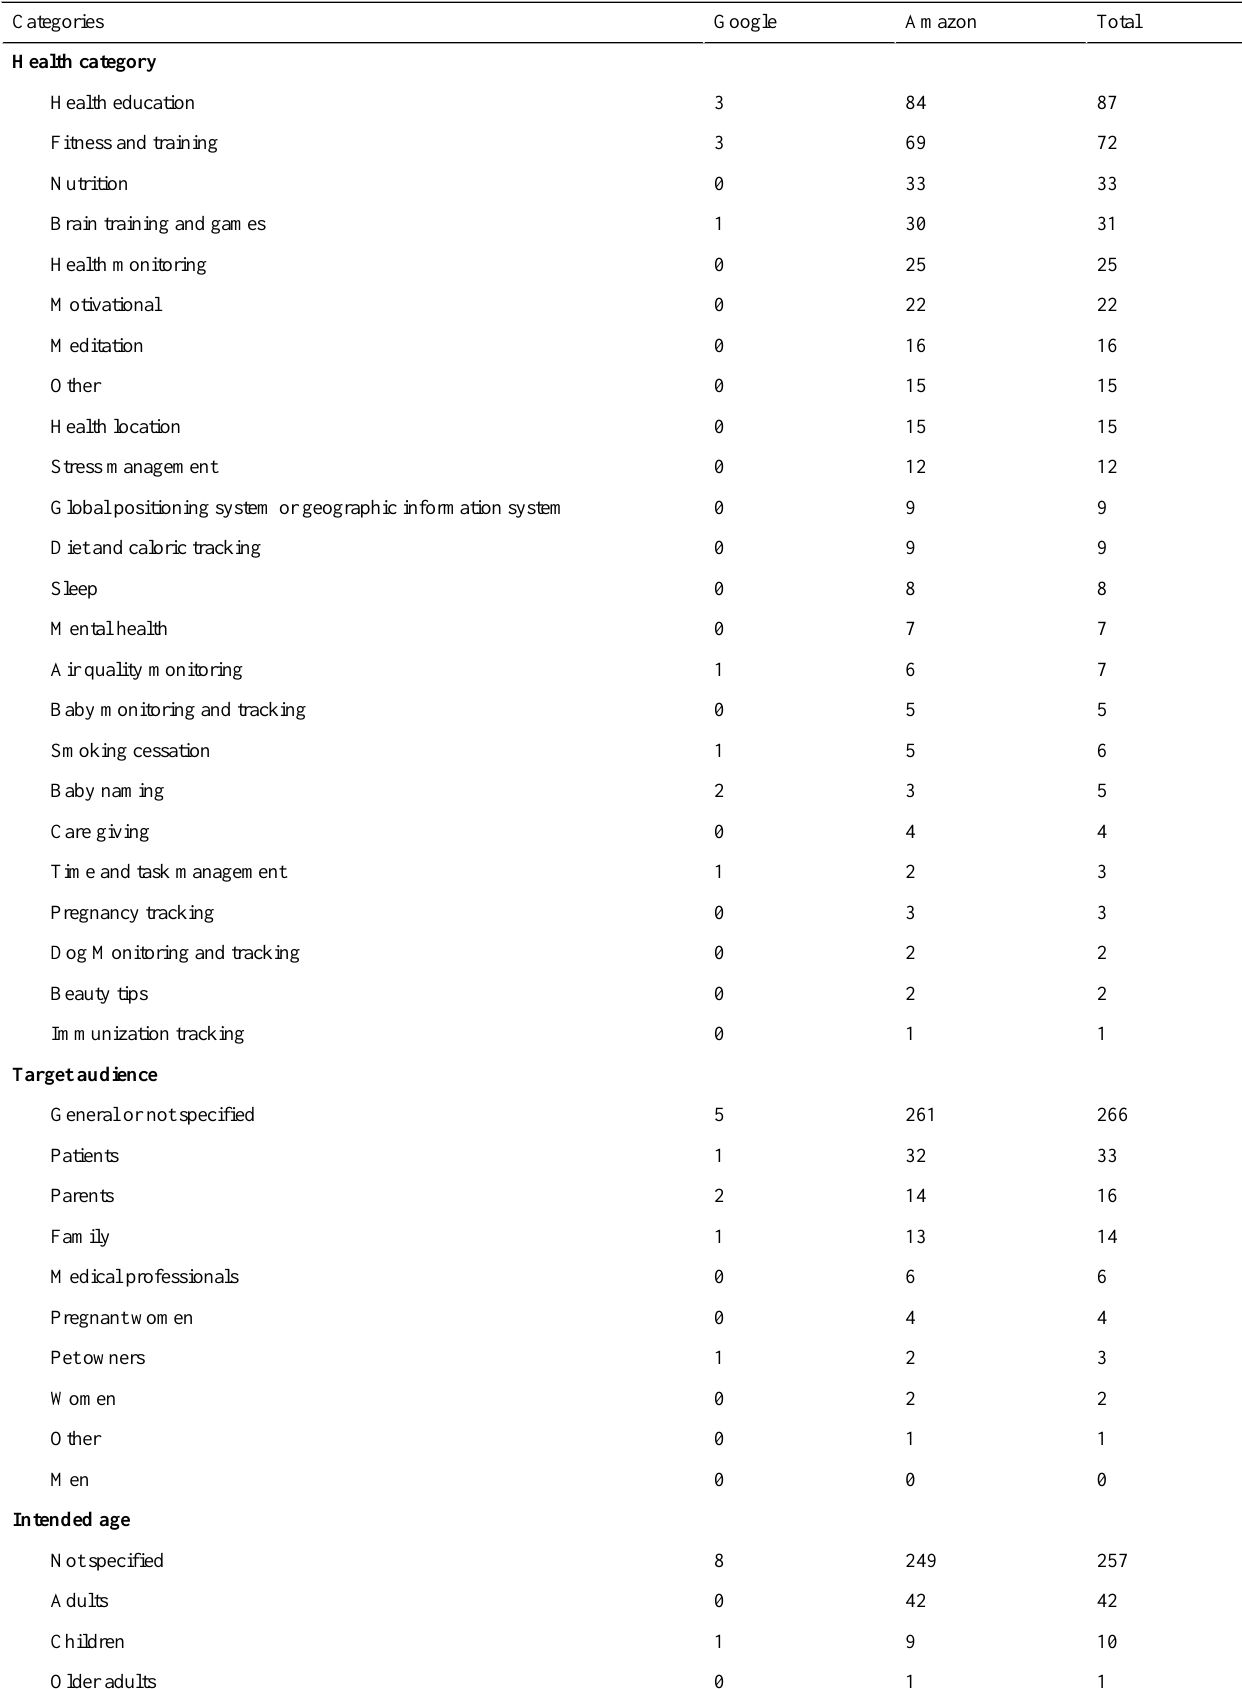
Table 3. Number of apps by health category, target audience, and age group (N=309). Apps could be included in multiple categories and were not mutually